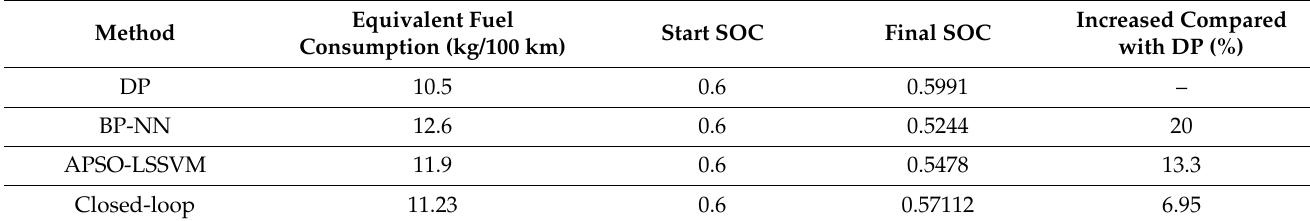
Table 6. EMS simulation